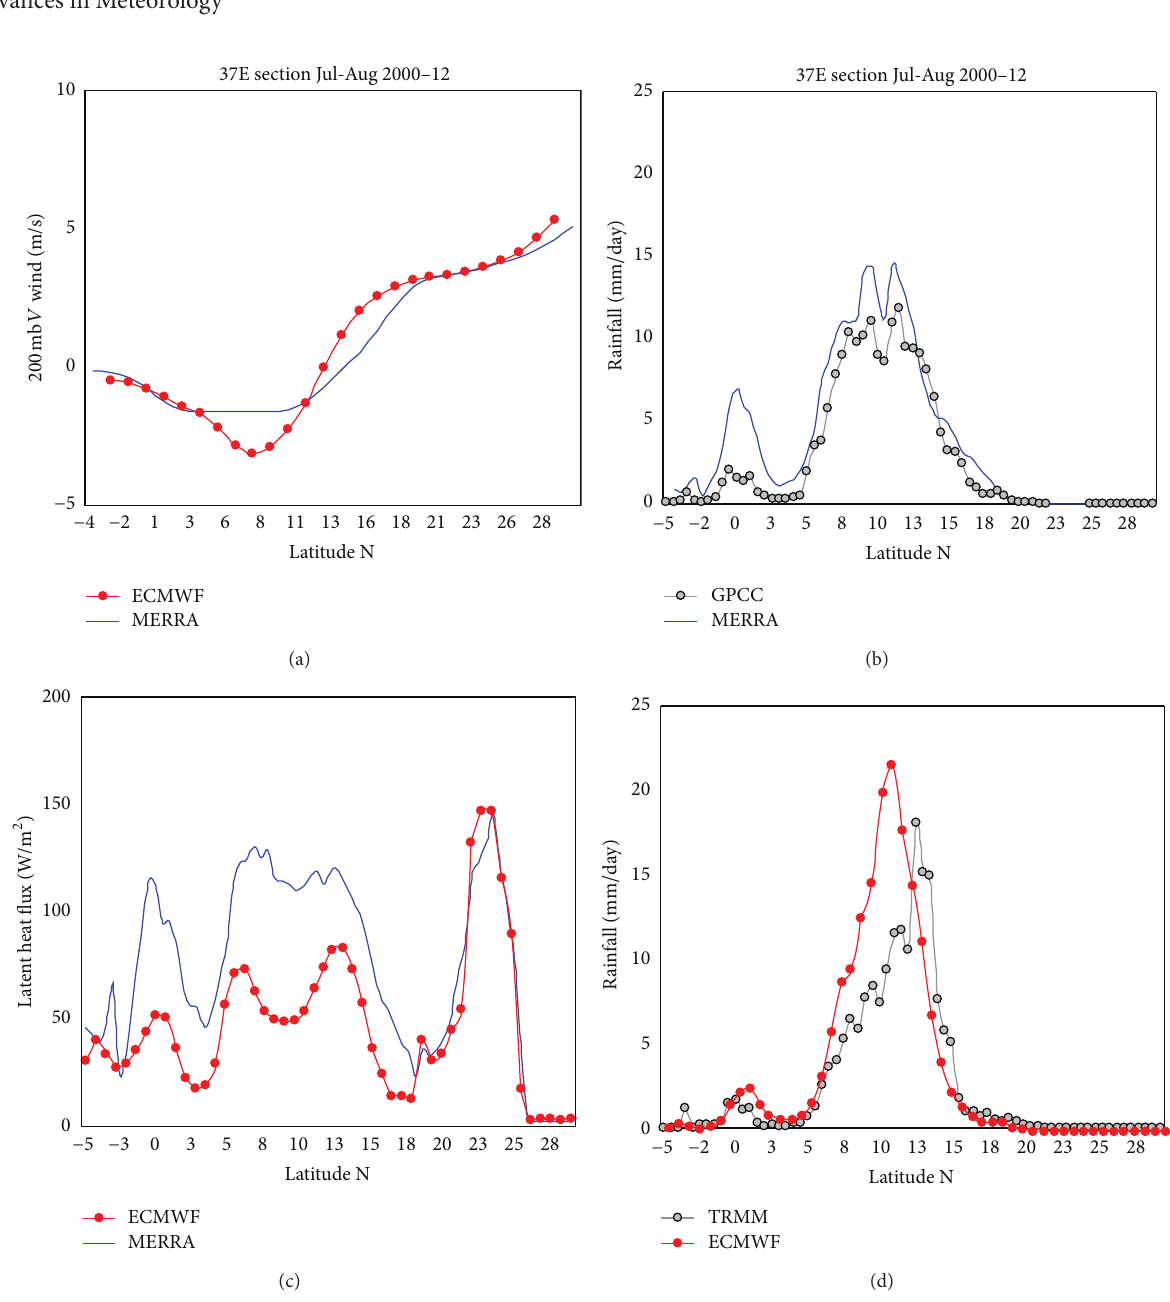
hour ensemble back-trajectories are calculated by the Hysplit model for an end-point at 11 ∘ N, 37 ∘ E, 1000, and 3000 m above ground using GFS data. Lastly mesoscale model simulations are compared with Meteosat cloud top temperatures.